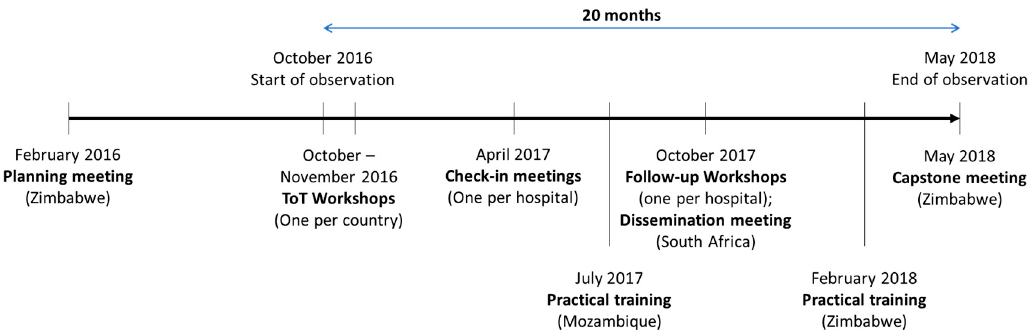
Figure 2. A timeline of the implementation of HealthWISE in seven selected hospitals in Mozambique, South Africa, and Zimbabwe.